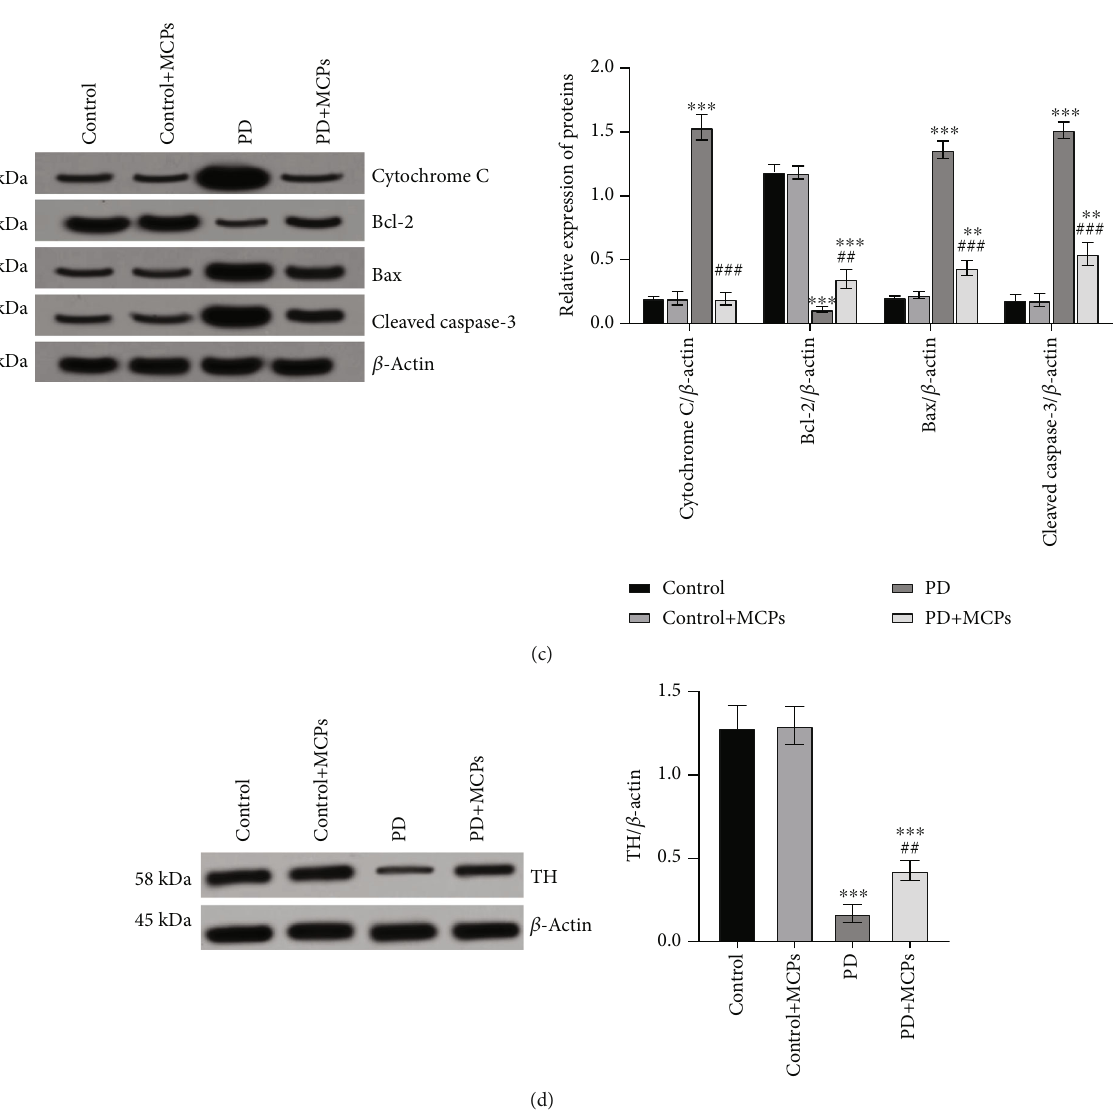
Figure 5: MCPs inhibit MPP + -induced apoptosis and reduce oxidative stress. (a) Flow cytometry to detect cell apoptosis rate after Annexin V-FITC/PI staining. (b) PI staining fl uorescence microscope to observe cell apoptosis. (c) The expression level of an oxidative stress-related protein Cytochrome C, and the expression levels of apoptosis-related proteins Bcl-2, Bax, and cleaved Caspase-3 in cells. (d) TH protein level in the cells. Compared with Control group (Control+MCPs group), ∗∗∗ P < 0 : 001 , compared with PD group, ## P < 0 : 01 , ### P < 0 : 001